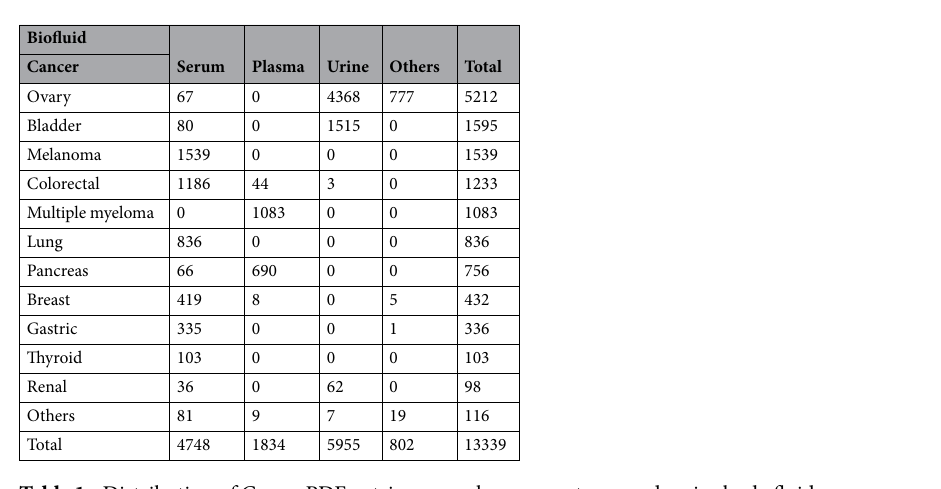
Table 1. Distribution of CancerPDF entries across key cancer types and major body